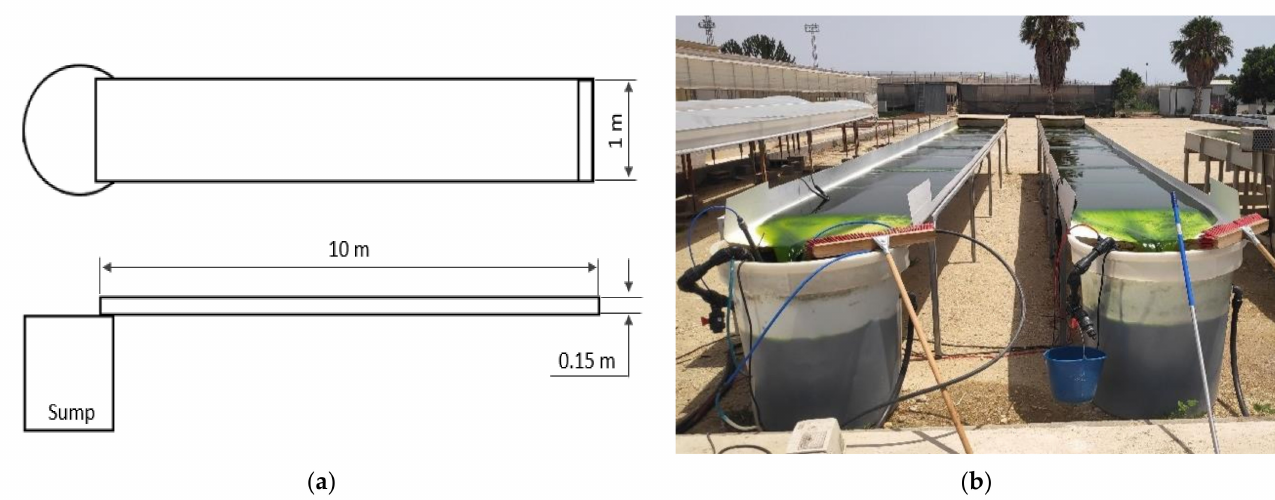
Figure 1. Thin-layer photobioreactors. ( a ) scheme (top and side view); ( b ) thin-layers view.